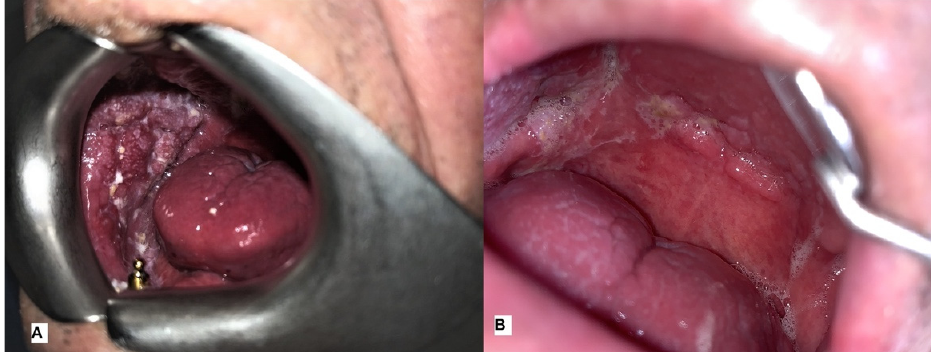
Figure 3. ( A ) Pre ‐ treatment image showing an erythroleucoplase exophytic non ‐ bleeding area with Figure 3. ( A ) Pre-treatment image showing an erythroleucoplase exophytic non-bleeding area with jagged margins of the buccal mucosa; ( B ) post ‐ treatment image showing scarring from a biopsy jagged margins of the buccal mucosa; ( B ) post-treatment image showing scarring from a biopsy and and ECT with no sign of malignancy. ECT with no sign of